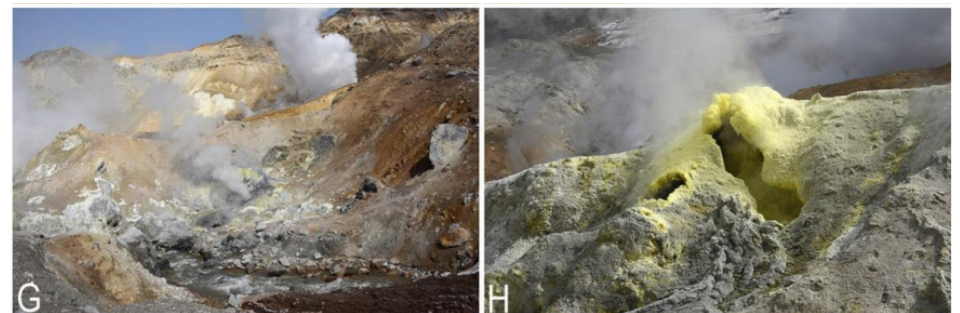
Figure 5. The foot of N-facing slope of Mutnovskaya Sopka Volcano, Falshivaya River basin: ( A ) Marsupella sphacelata is dominating here, 1110 m a.s.l.; ( B ) Plectocolea vulcanicola on sulfurous strata, 1110 m a.s.l., ( C ) sulfurous thermal field, 1054 m a.s.l.; ( D ) sulfurous stream on thermal field, Plectocolea vulcanicola and Cladopodiella francisci on sulphur-rich soil, 1054 m a.s.l.; ( E ) sulfurous thermal field, Plectocolea vulcanicola , Marsupella sphacelata on the border of the field, 1054 m a.s.l. ( F ) Dachnye Hot Springs, steam is going from fumaroles, 790 m a.s.l.; ( G , H ) the crater of Mutnovskaya Sopka Volcano, fumaroles and thermal fields on the border of Mutnovsky Glacier, no liverworts or other plants were found here, 1480 m a.s.l. (Photo by K.G. Klimova, 2021).